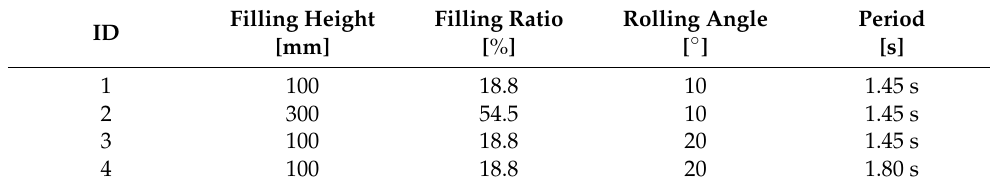
Table 5. Description of the numerically computation